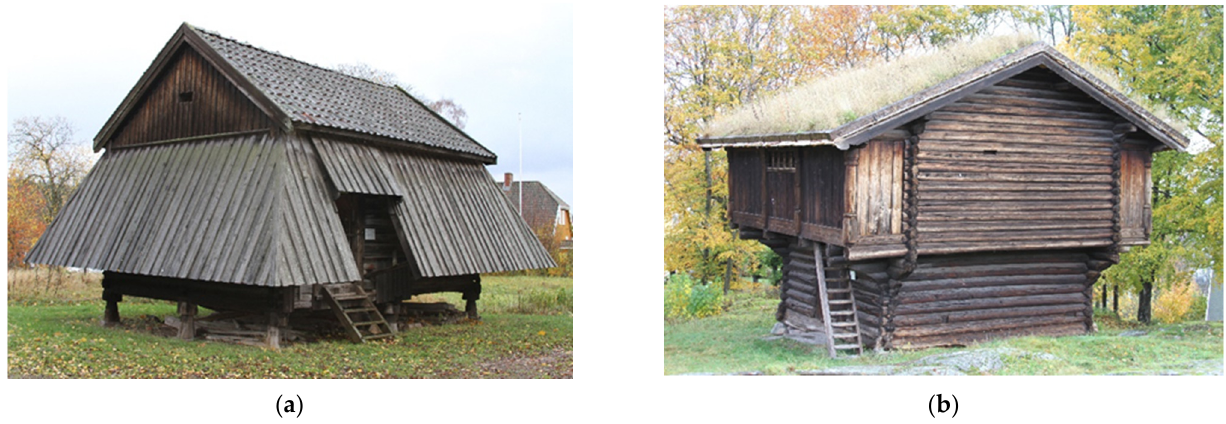
Figure 1. Photographs of ( a ) the Fadum storehouse and ( b ) the Heierstad loft taken from south-west. The Fadum storehouse is a two-storey building and is dated back to 1820. In 1958, it was moved to its current location at the Slottsfjellet hill. It has a rectangular plan, with its major axis east–west oriented. Its entrance is in the southern façade. Its unique design features are the pillars or stumps upon which it stands and the shed or coating that surrounds the main body of the building. It also has openings in the eastern and western façade, both in the ground and upper floor. The stumps contribute to keeping the lower part of the construction dry, since they protect it from the ground rising damp, and they